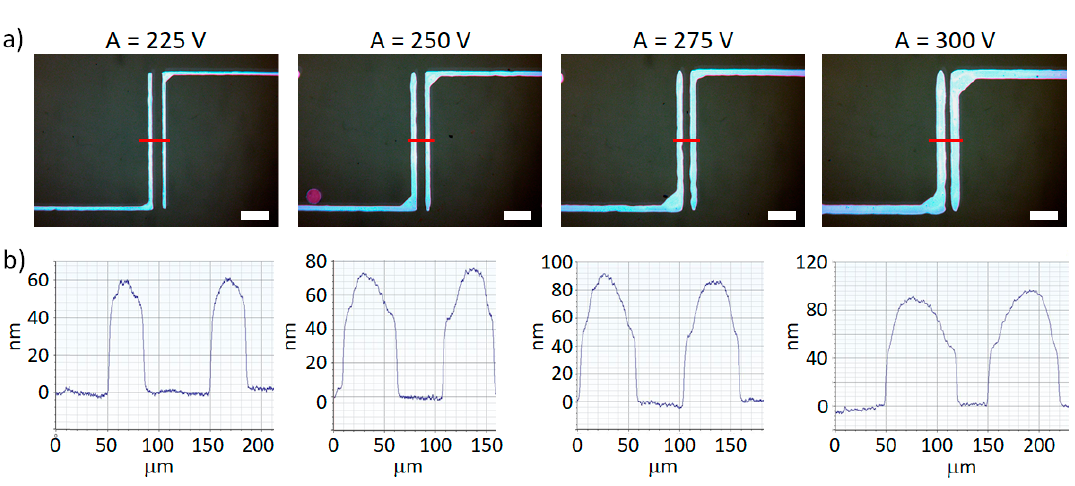
Figure 3. ( a ) Optical microscope images of DGP printed lines on plasma-treated SiO 2 surface with different amplitudes ( A ). ( b ) Cross-section profiles of the respective overprints. B = 200 V, f = 500 Hz, s = 100 µ m. Scale bar equal 200 µ m.